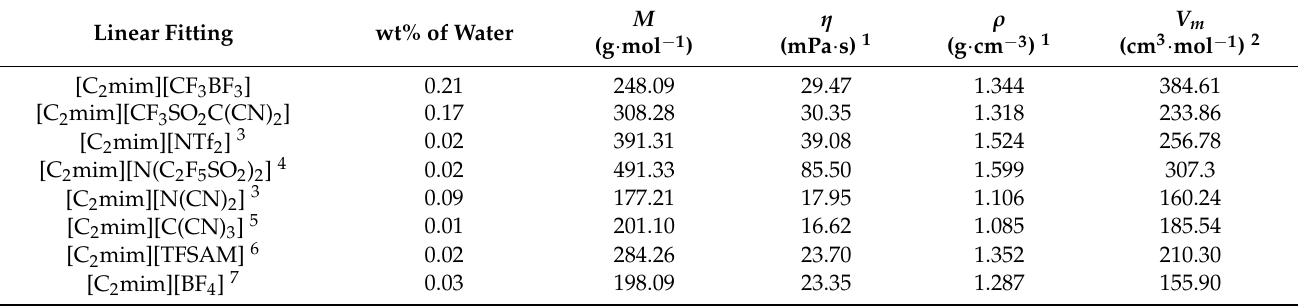
Comparison of density, viscosity, and molar volume of [C 2 mim][CF 3 BF 3 ] and [C 2 mim][CF 3 SO 2 C(CN) 2 ] with those of other ILs bearing anions with the same moieties at 298.15 K and atmospheric